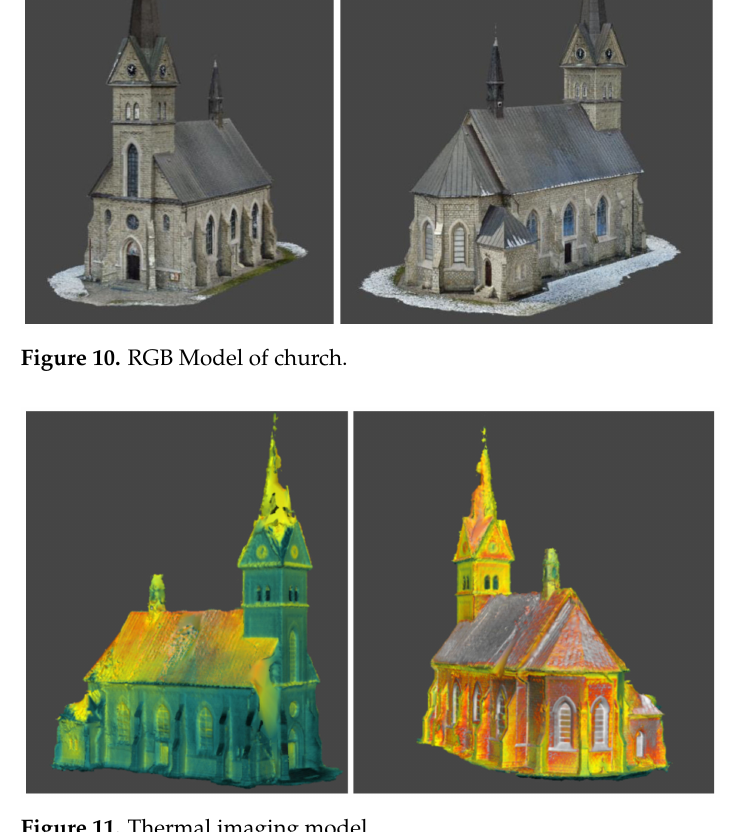
Figure 11. Thermal imaging